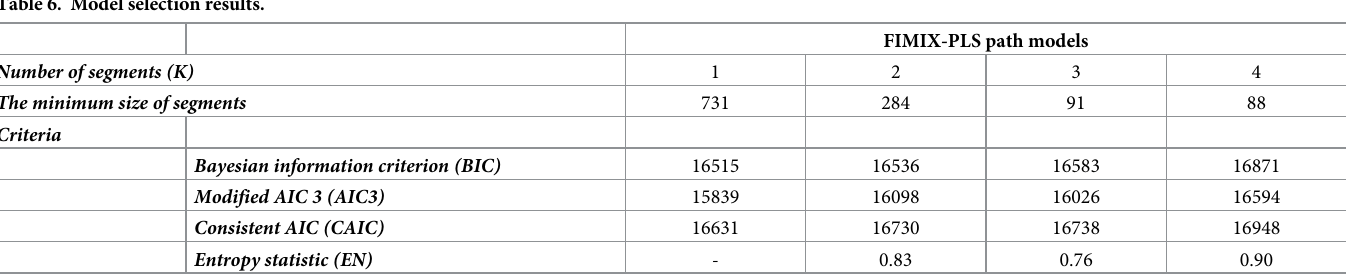
Table 6. Model selection